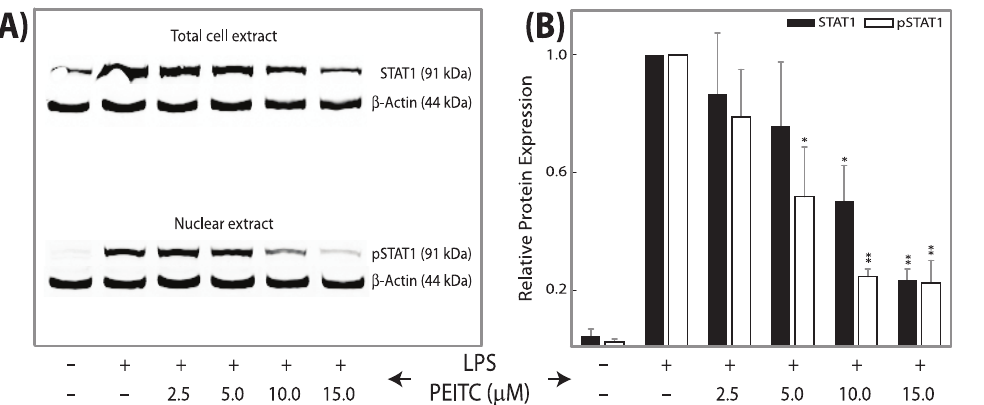
Figure 6. Immunoblot analyses showing suppression of total cellular STAT1 as well as activated nuclear pSTAT1 in response to PEITC treatments in SW480 cells in a concentration-dependent manner. (A) Immunoblot. (B) Densitometric analyses of immunoblot. Cells were pre-treated with various concentrations of PEITC for 5 h prior to 4 h LPS activation. Unstimulated cells and stimulated cells served as negative and positive controls. Band intensities were normalized to b -actin. Values are expressed as means 6 SEM (n=3) of three separate experiments.